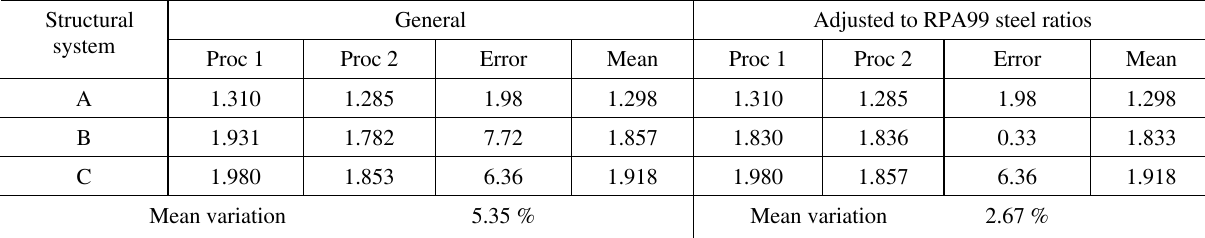
Table 4 . Period amplification coefficient α considering site effect